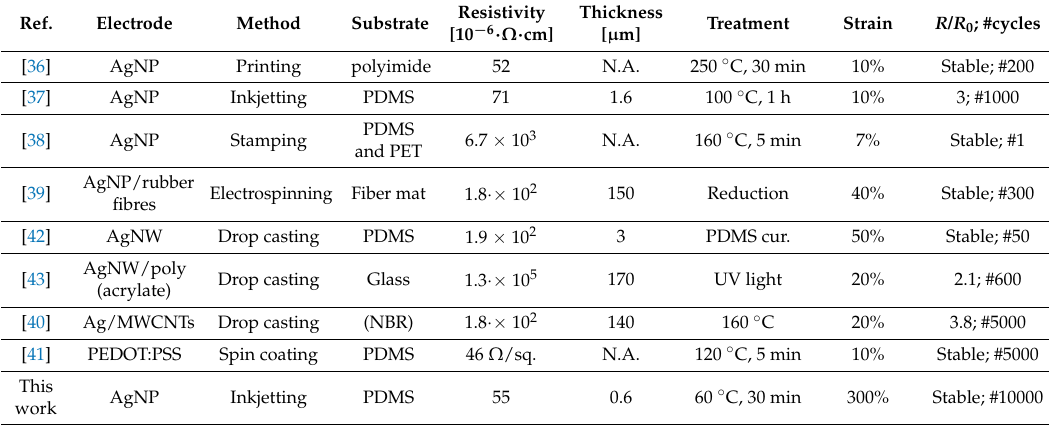
Table 1. Summary for the manufacturing and material properties of stretchable conductors including this